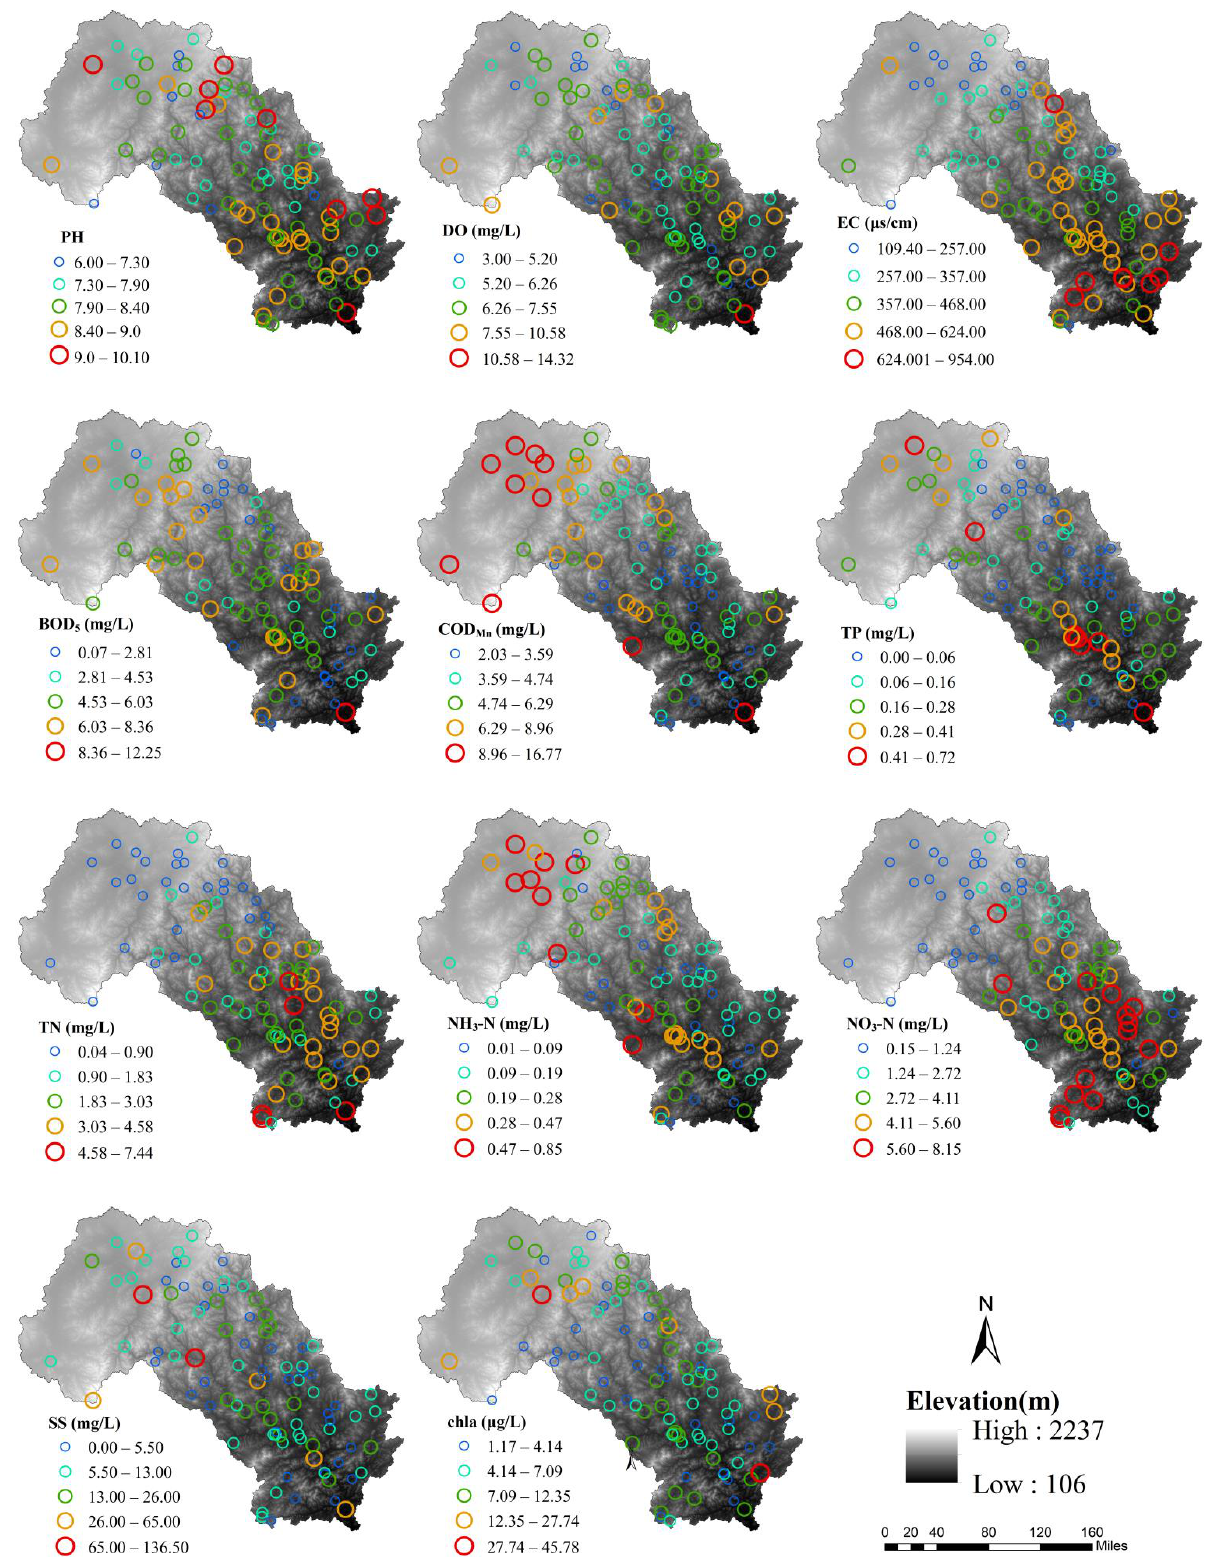
Figure 4. The spatial variations in the water quality parameters in the Luanhe River basin.